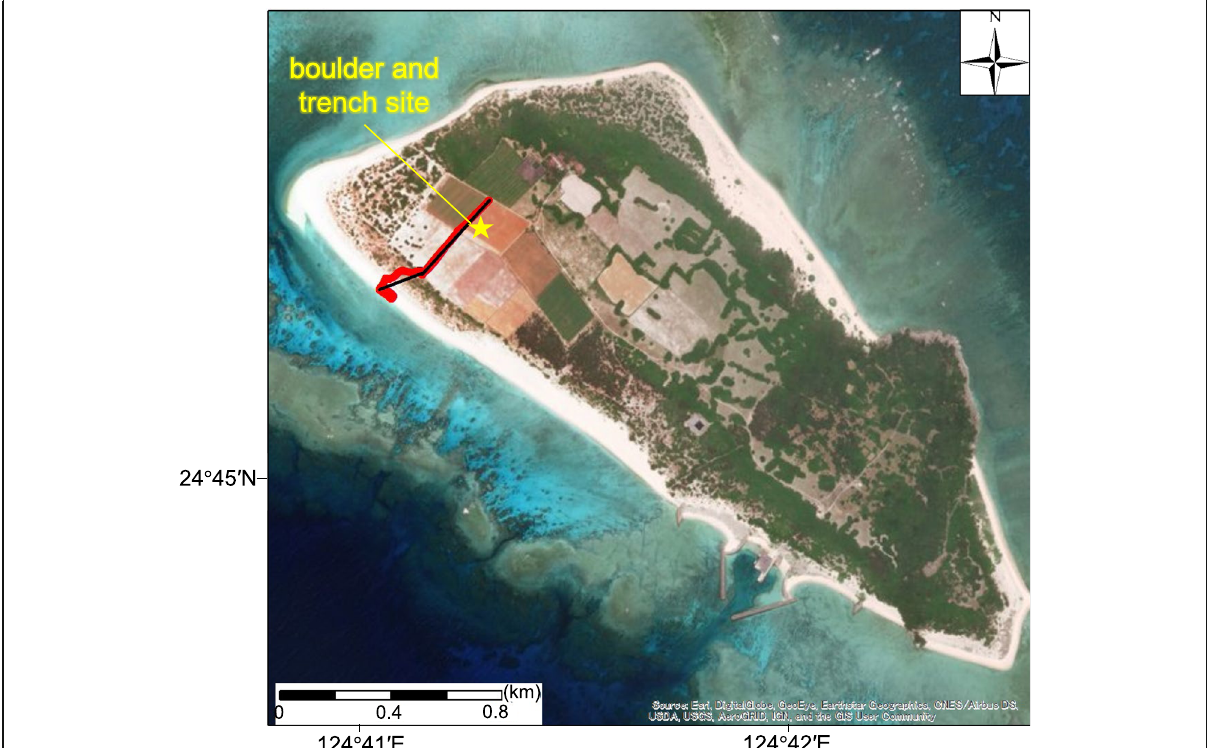
Fig. 2 Aerial photograph of Minna Island: the red line shows an actual route of Ground-Penetrating Rader (GPR) survey; the black line shows the projected line used to depict cross-sectional subbottom profile in Fig.